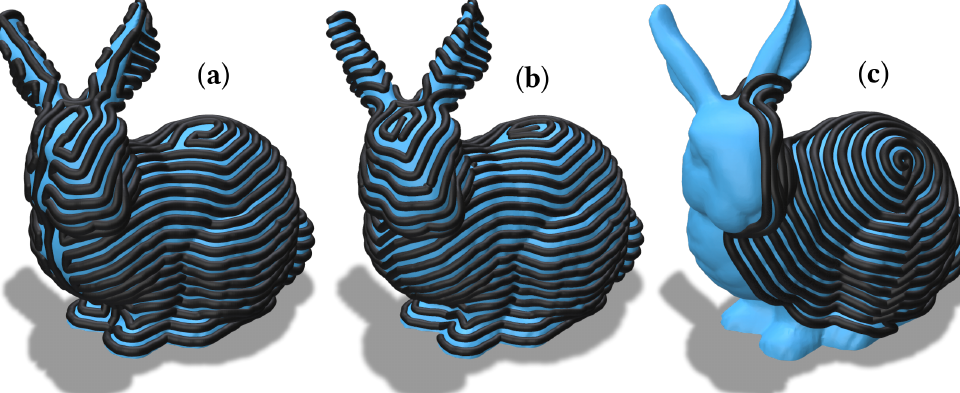
Figure 4. Contour parallel algorithms and resulting paths on the Stanford bunny. Travel motions not displayed. With d = 3.5 mm ( a ) Geo-FISO, ( b ) Geo-Contour, ( c ) Geo-Spiral. Filament thickness displayed does not correspond to thickness when